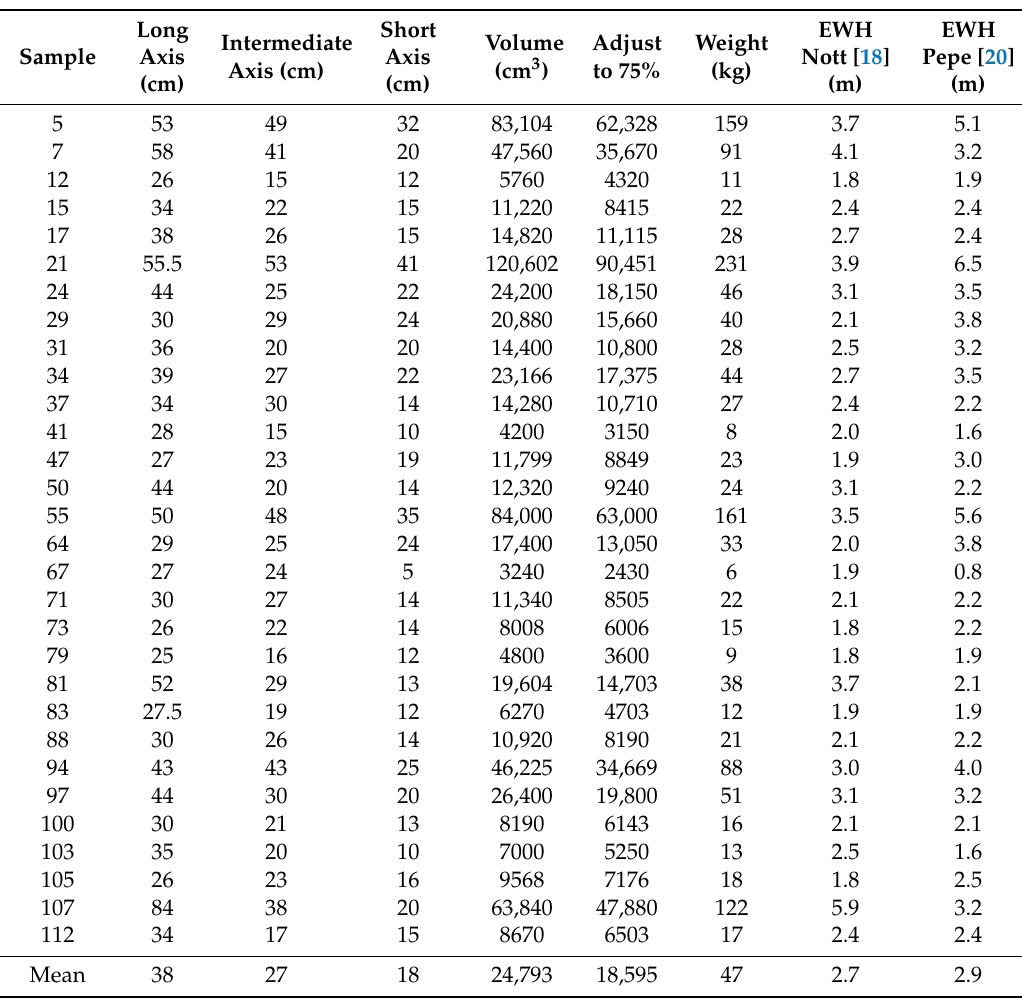
Table A7. Quantification of boulder size, volume, and estimated weight from selected coastal bar samples through transect 7 at Bah í a San Luis Gonzaga. EWH = estimated wave height. The density of Baja Californian andesite at 2.3 gm / cm 2 is applied uniformly in order to calculate wave height for each